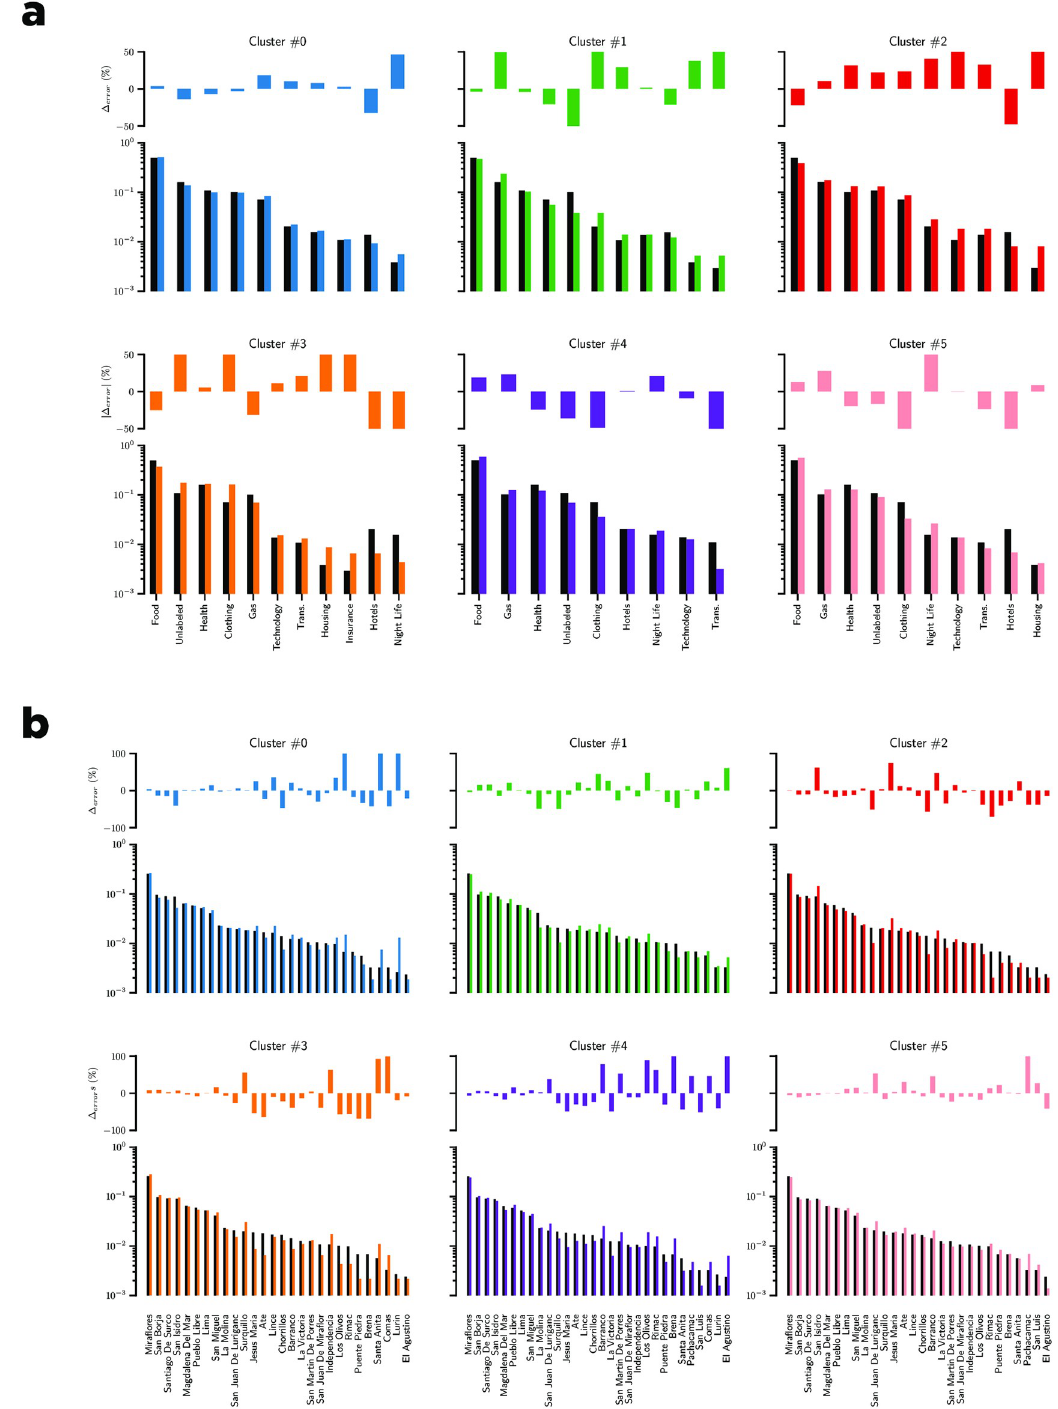
Fig 8. Proportion of merchant categories/area inside different clusters. a ) Proportion of merchants per cluster as a function of their Classification of Individual Consumption According to Purpose (COICOP), b ) Proportion of merchants per cluster as a function of their district area. The top of each figure indicates the relative differences between the proportion of a given category inside a cluster and the proportion of that category in our dataset.